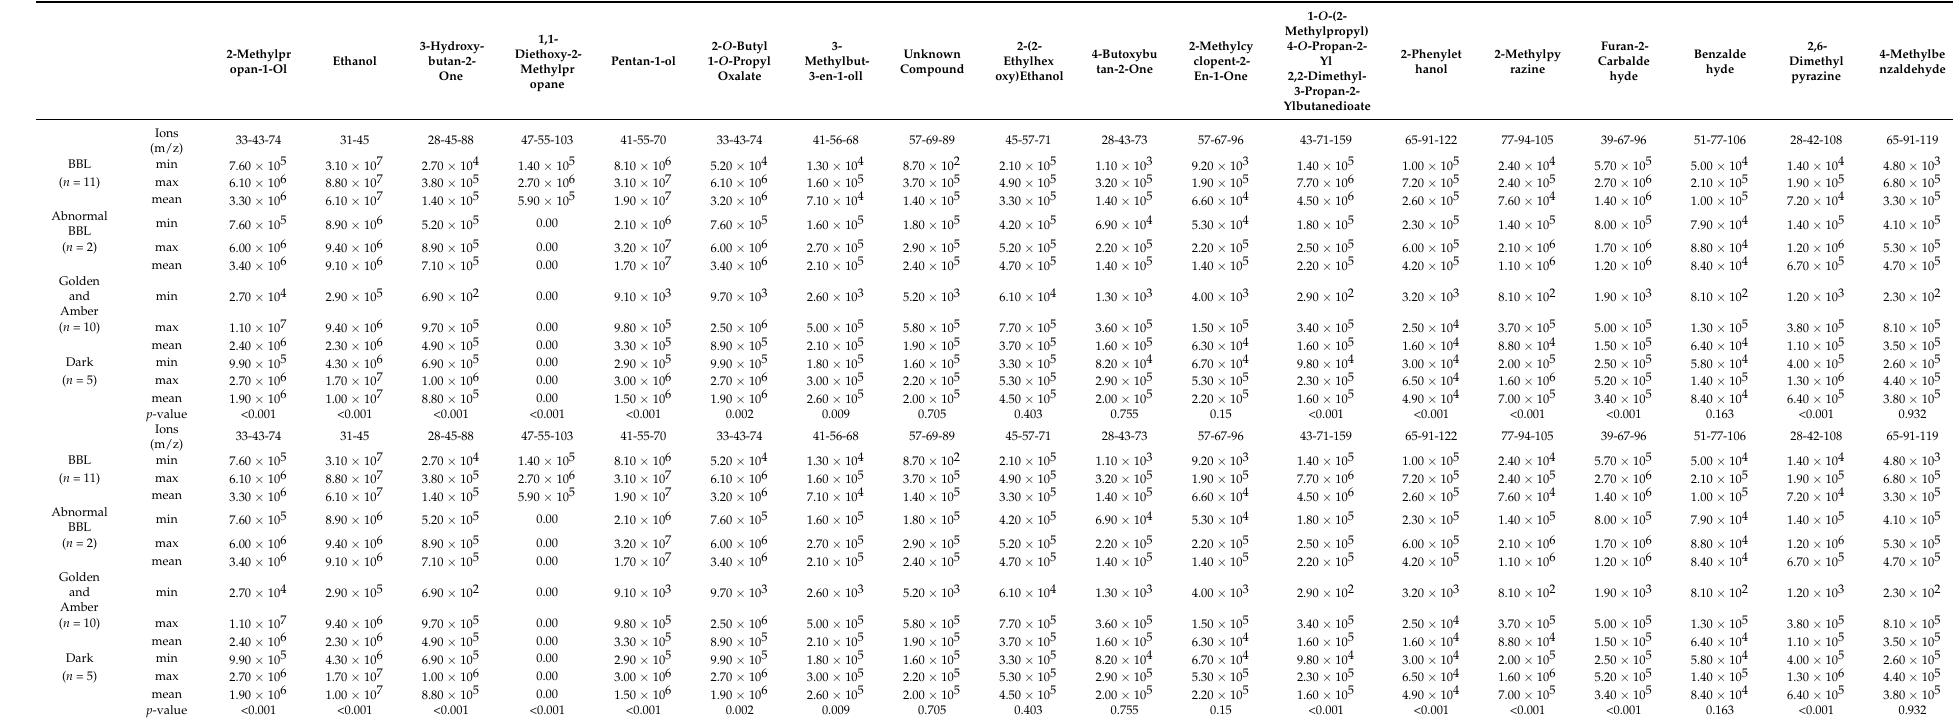
Table A1. Summarization of 18 tentatively identified volatile compounds from maple syrup samples utilizing